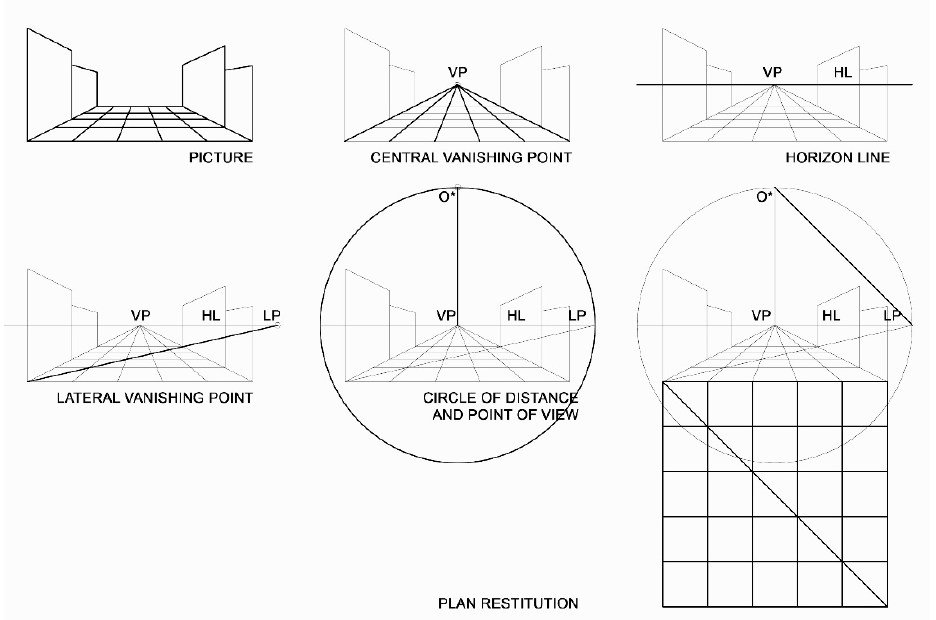
Figure 1. Preliminary stages of the procedure of perspective restitution to reconstruct the perspective structure of a picture and draw the plan of its chequered floor.